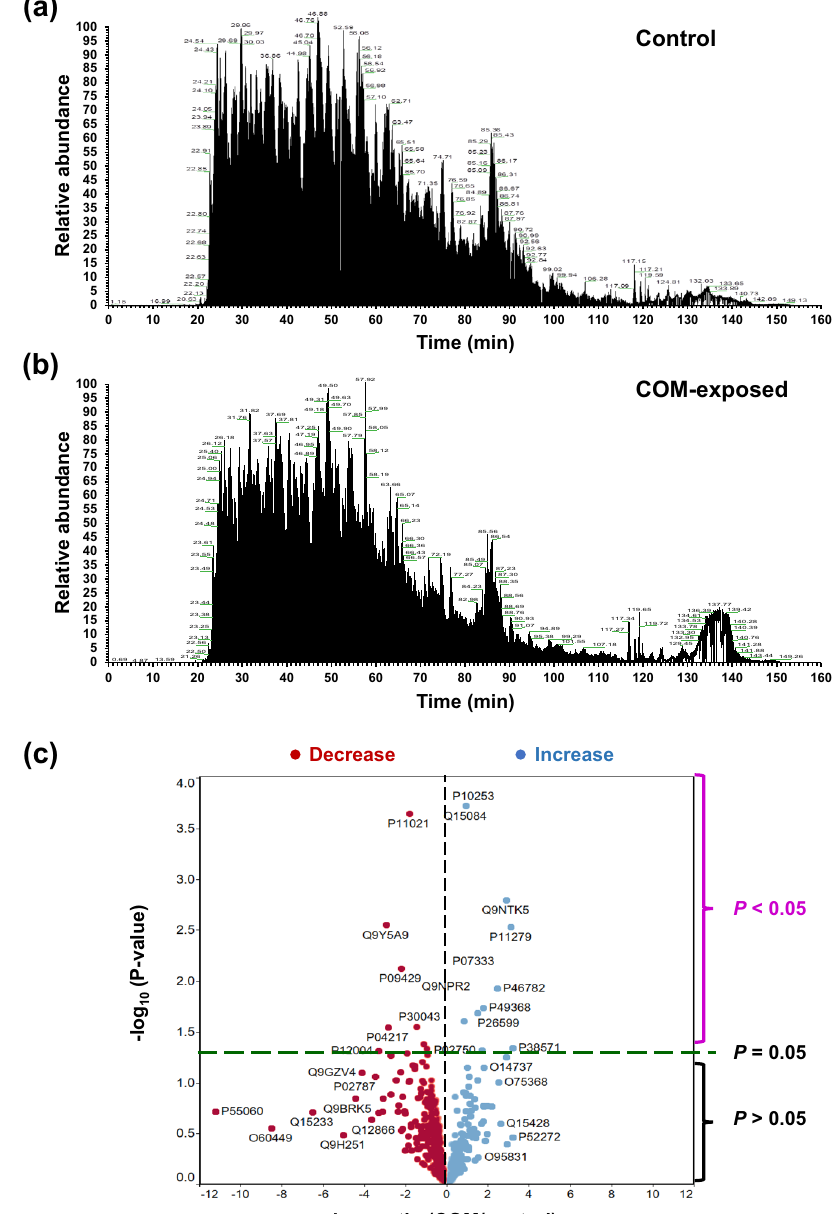
Fig. 2 Label-free quantitative proteomics analysis of secretome derived from macrophages using nanoLC-ESI-LTQ-Orbitrap MS/MS. a Representative total ion chromatogram (TIC) of secretome derived from the control macrophages. b Representative TIC of secretome derived from the COM-exposed macrophages. c Volcano plot to demonstrate the relationship between differential ratios (COM/control) and P -values of all 598 identi fi ed proteins. All the source data have been deposited to the ProteomeXchange Consortium (http://www.proteomexchange.org/) via the PRIDE (https://www.ebi.ac.uk/ pride/) partner repository with the dataset identi fi er PXD027039 and 10.6019/PXD027039. Proteins with P < 0.05 were considered as signi fi cantly altered secreted Label-free quantitative proteomics analysis of differentially secreted proteins from COM-MP vs. Ctrl-MP . Macrophages were incubated in serum-free medium with or without 100 µg/ml COM crystals for 16 h. The culture supernatants were collected, clari fi ed and subjected to label-free quantitative proteomics ana- lysis using three independent biological samples per group, and each sample was run in technical triplicates. Therefore, nine mass spectral pro fi les were obtained from each group for reliable quantitative analysis. Total ion chromatogram (TIC) representing the chromatographic pro fi le (retention time vs. relative